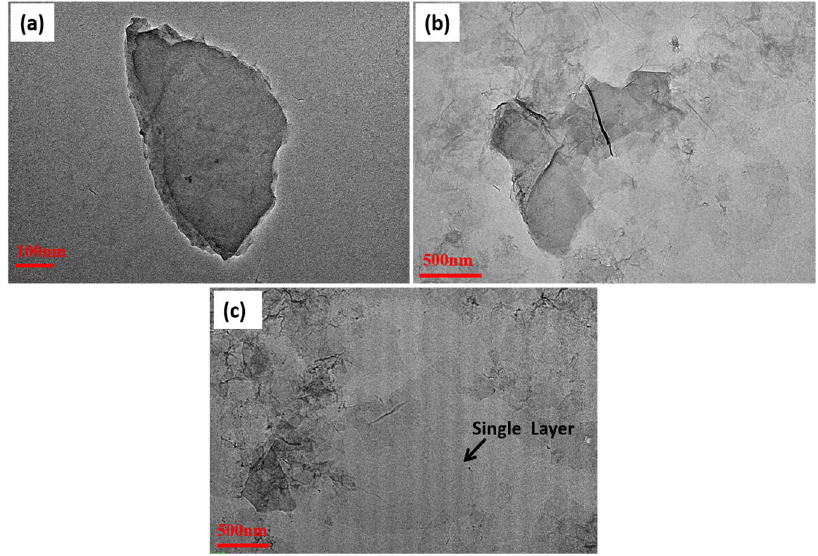
Figure 2. HRTEM images of GO as a function of ultrasonication time ( a ) 1 h, ( b ) 3 h, and ( c ) 5